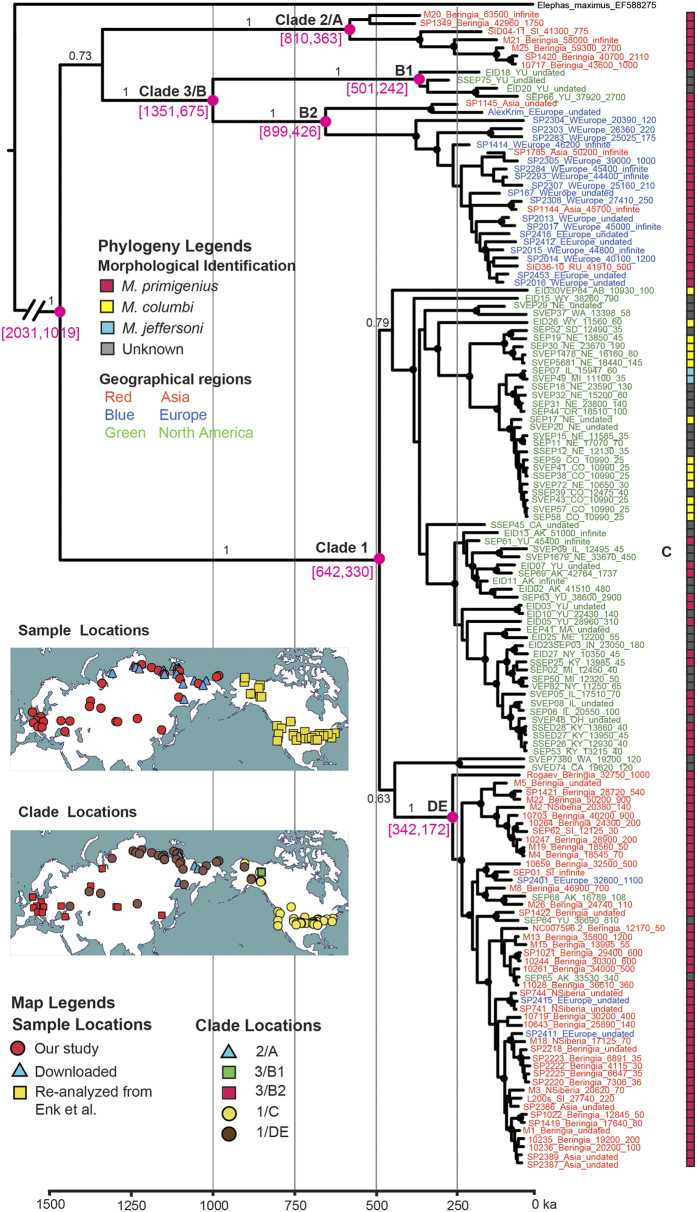
Maximum Clade Credibility (MCC) phylogeny resulting from a BEAST analysis of the relaxed data set.The molecular clock was informed using the root-and-tip-dating method. Morphology-based taxonomic identifications are provided as rectangular bars to the right of sample names. Nodes leading to major clades are labeled and highlighted as magenta dots, with the inferred tMRCA (95% highest posterior density of node ages, magenta numbers below the branch leading to the clade). Posterior probability for each clade is provided either as black numbers along branch leading to major clades, or indicated as >95% by the presence of a black dot. The timescale is offset by 4651 years, which is the age of the youngest sample in the data set. (Inset) Maps describing the geographic location of (a) samples used in this study and (b) the clade and haplogroup information of those samples. Map from http://www.d-maps.com/carte.php?num_car=3212&lang=en.